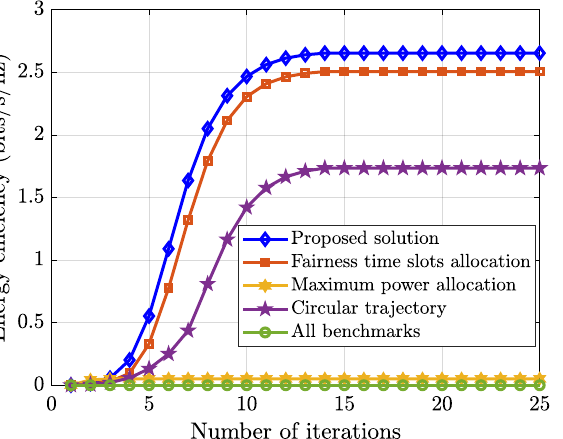
Figure 6. Maximum EE versus number of iterations comparing the proposed solution to other benchmarks when N = 5, L =